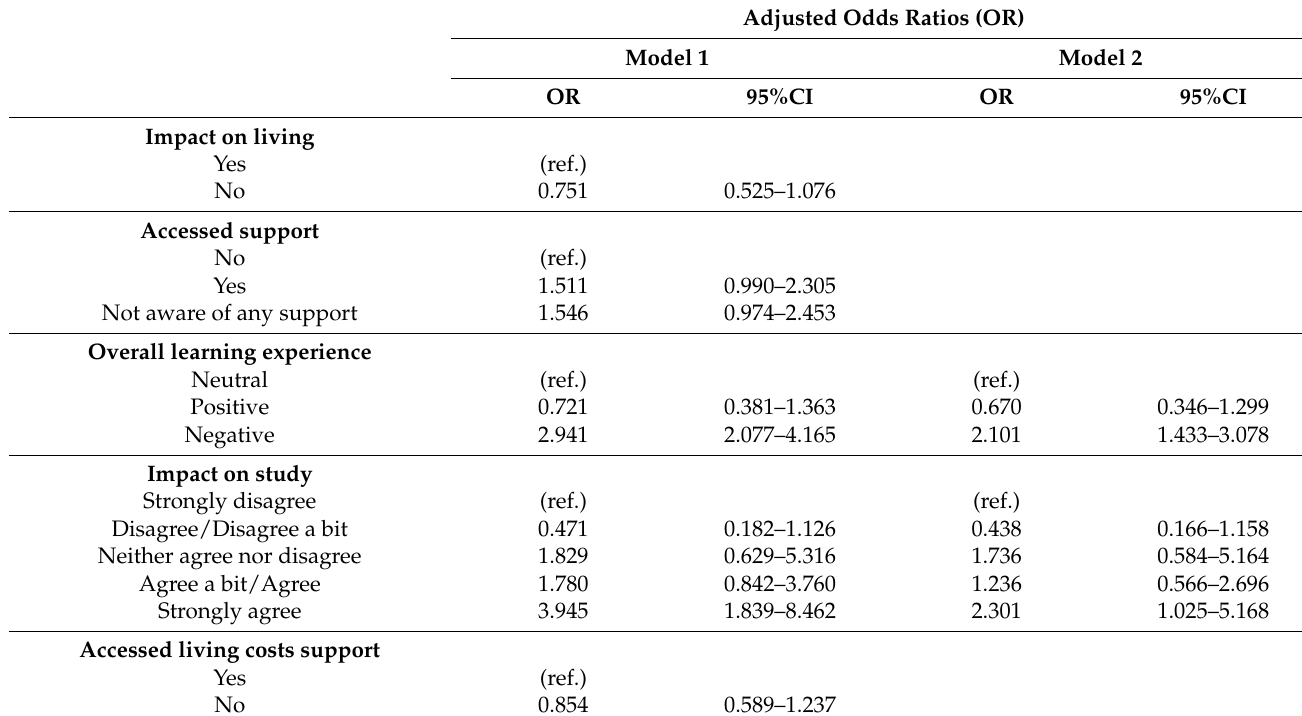
Table 5. Multivariable model examining learning experience associated with lower (<50) wellbeing (N =